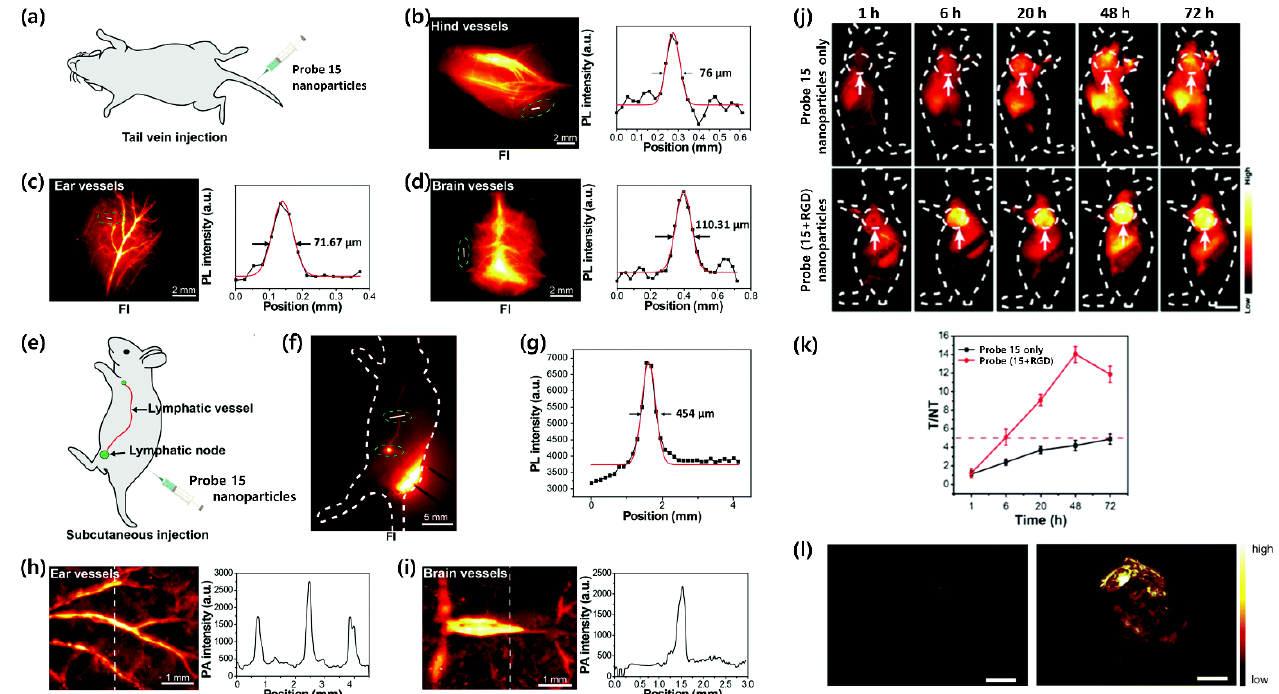
Figure 11. Probe 15 nanoparticle-based imaging in vivo. ( a ) Schematic illustration of intravenous injection of the probe nanoparticles through the tail vein of a mouse. ( b – d ) Representative NIR-II fluorescence images of the hindlimb vasculature ( b ), ear vessels ( c ), and brain vessels ( d ) in the mouse upon intravenous injection of 100 mg of the probe nanoparticles. ( e ) Schematic illustration of subcutaneous injection of the probe nanoparticles for lymphatic imaging. ( f ) Representative NIR-II fluorescence image of the lymphatic vessels and lymph nodes in a mouse injected with the nanoparticles. ( g ) Cross-sectional fluorescence intensity profile (and Gaussian fit) along the red line, circled in green, in panel ( f ). PAM imaging of the ear vessels ( h ) and brain vessels ( i ) from a mouse injected with the probe nanoparticles through the tail vein. ( j ) Representative NIR-II FLI in 143B tumor-bearing mice using the probe-based nanoparticles over 72 h under excitation by an 808 nm diode laser (140 mW cm − 2 ); filter: 1000 nm LP. Arrows indicate the subcutaneous tumor ( n = 4 per group). Scale bar: 5 mm. ( k ) T/NT ratios in probe nanoparticle-based 143B tumor imaging over 72 h. Data are plotted as mean and standard deviation ( n = 4). ( l ) Three-dimensional volume rendering of photoacoustic images (excitation at 730 nm) of the 143B tumor in a mouse 48 h post-injection of the probe nanoparticles without (left) or with (right) RGD peptide decorated on the surface. Scale bar = 2 mm. Reprinted with permission from Ref. [111] . Copyright 2021, Royal Society of Chemistry.